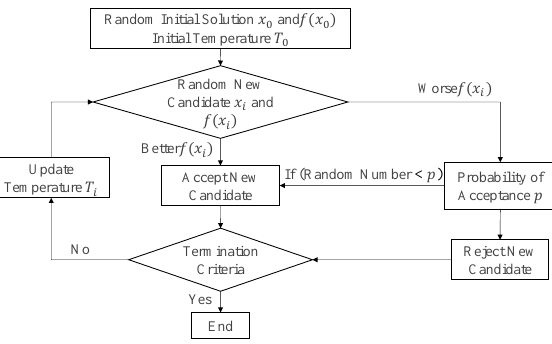
Figure 1. Flowchart of the simulated annealing method